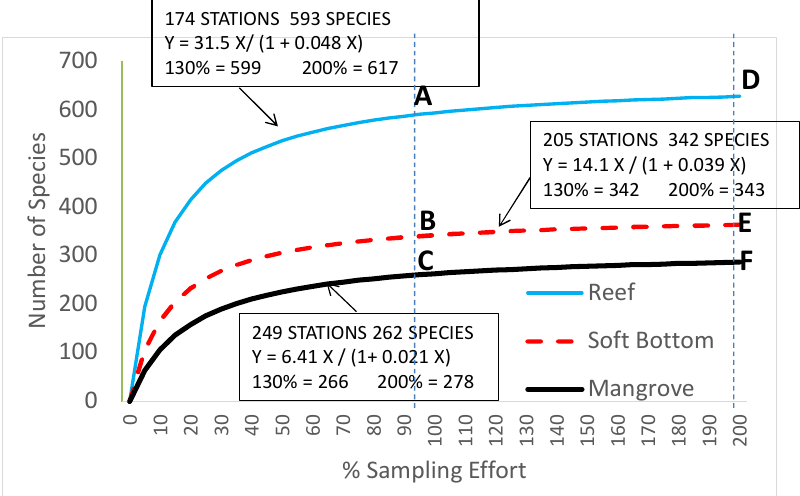
Figure 2. Modelled cumulated number of species with sampling effort (in the equations X = number of stations) for reefs (174 stations), soft-bottoms (342 stations), and mangroves (249 stations). 100% ( A – C ) corresponds to the total sampling effort of the study. 200% ( D – F ) indicates a doubling of the sampling effort. All 3 relationships have r² = 0.98.